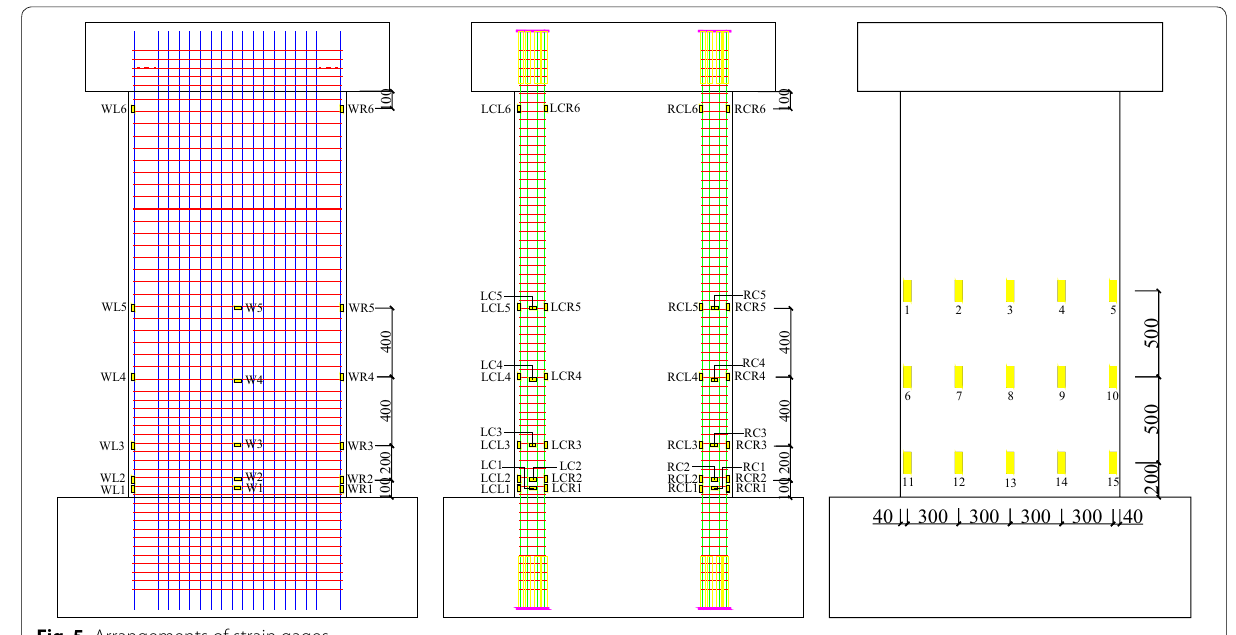
Fig. 5 Arrangements of strain